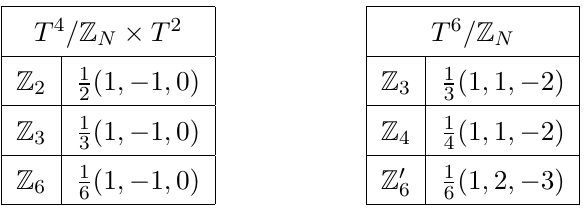
Figure 4 . Orbifold compacti(cid:12)cation: identi(cid:12)cation under Z orbifold twist kv (that we will call (cid:13) , see eq. (3.37)) will occur in all our